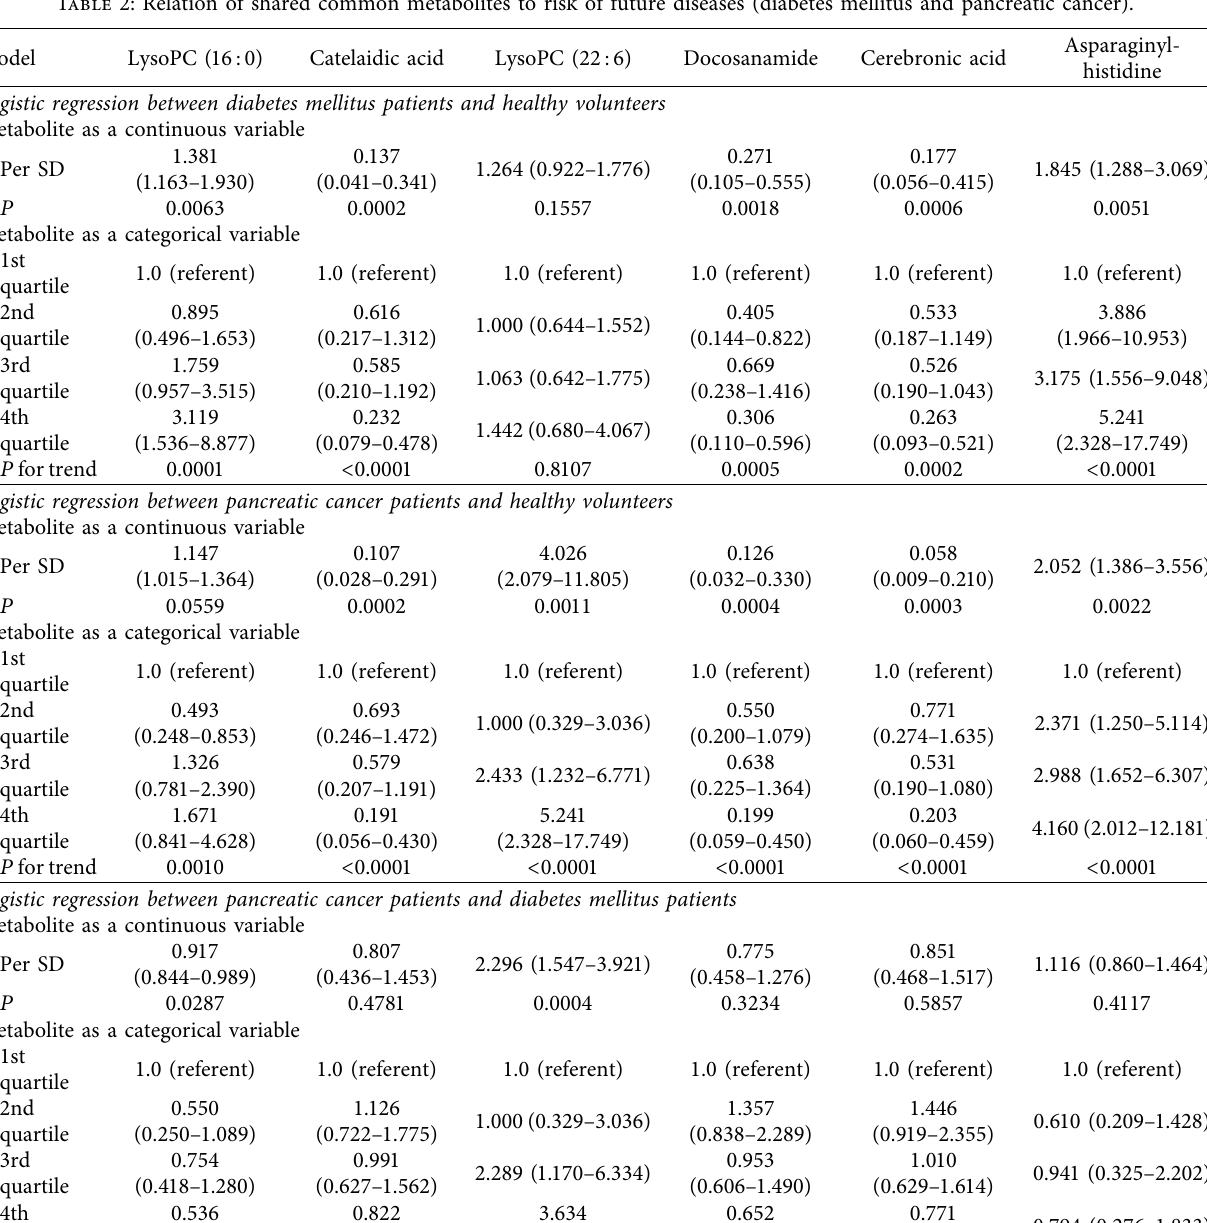
Table 2: Relation of shared common metabolites to risk of future diseases (diabetes mellitus and pancreatic